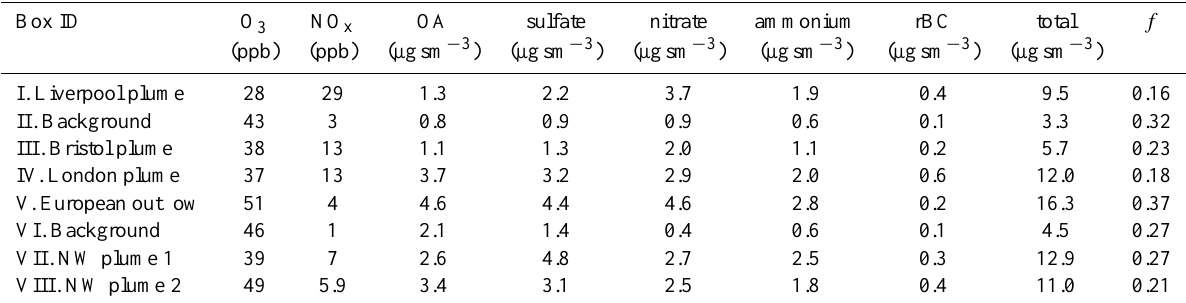
Fig. 2. Maps showing the ratio of ozone-to-nitrogen oxides mixing ratios (a–b , note logarithm scale) and sub-micron aerosol mass con- centrations measured by the AMS and SP2 (c–d) . Only periods when the aircraft was flying at a level altitude in the boundary layer are highlighted. Solid black line shows the flight track. Locations of major cities and selected regions are also indicated. Table 1. Mixing ratios of ozone and nitrogen oxides, aerosol mass concentrations, and the number fraction of thickly coated refractory black carbon particles ( f ) averaged over air mass boxes identified in Fig.